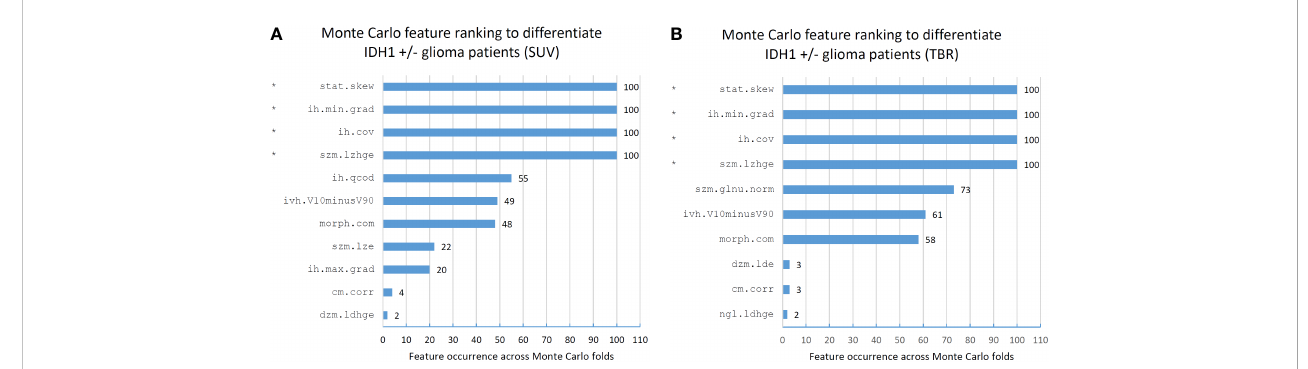
FIGURE 4 Feature occurrences of the 10 highest-ranking features per Monte Carlo fold that separate IDH1+/- patients in standard uptake value (SUV)-based (A) and tumor-to-background ratio (TBR)-based (B) radiomic datasets. Co-occurring high-ranking features in both SUV and TBR datasets are denoted by “ * ” . Features are denoted by their Imaging Biomarker Standardization Initiative (IBSI) identi fi ers. For the names of each feature see Supplemental Table